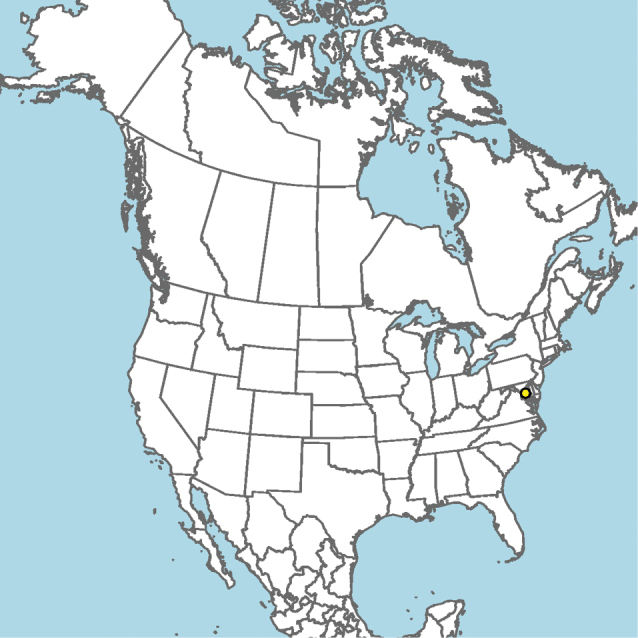
Occurrence record of E.
andriyi known to the author (yellow circle).